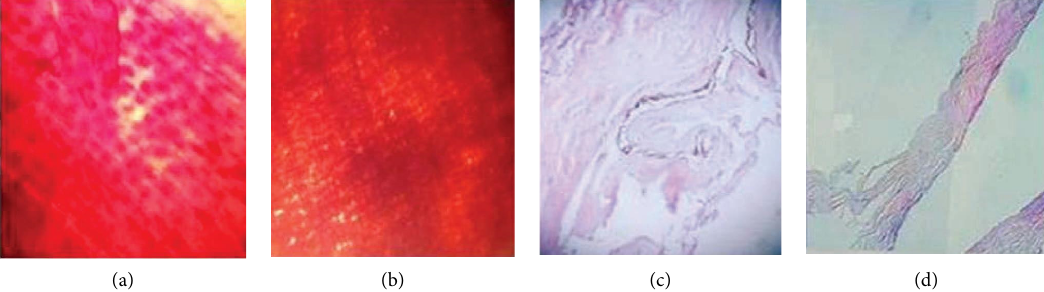
Figure 5: H&E staining of the fsh skin before and after decellularization. Cross-sectional analysis of the fsh skin at 10x: (a) before decellularization and (b) after decellularization. Te sagittal section analysis of the fsh skin at 40x: (c) before decellularization and (d) after decellularization.